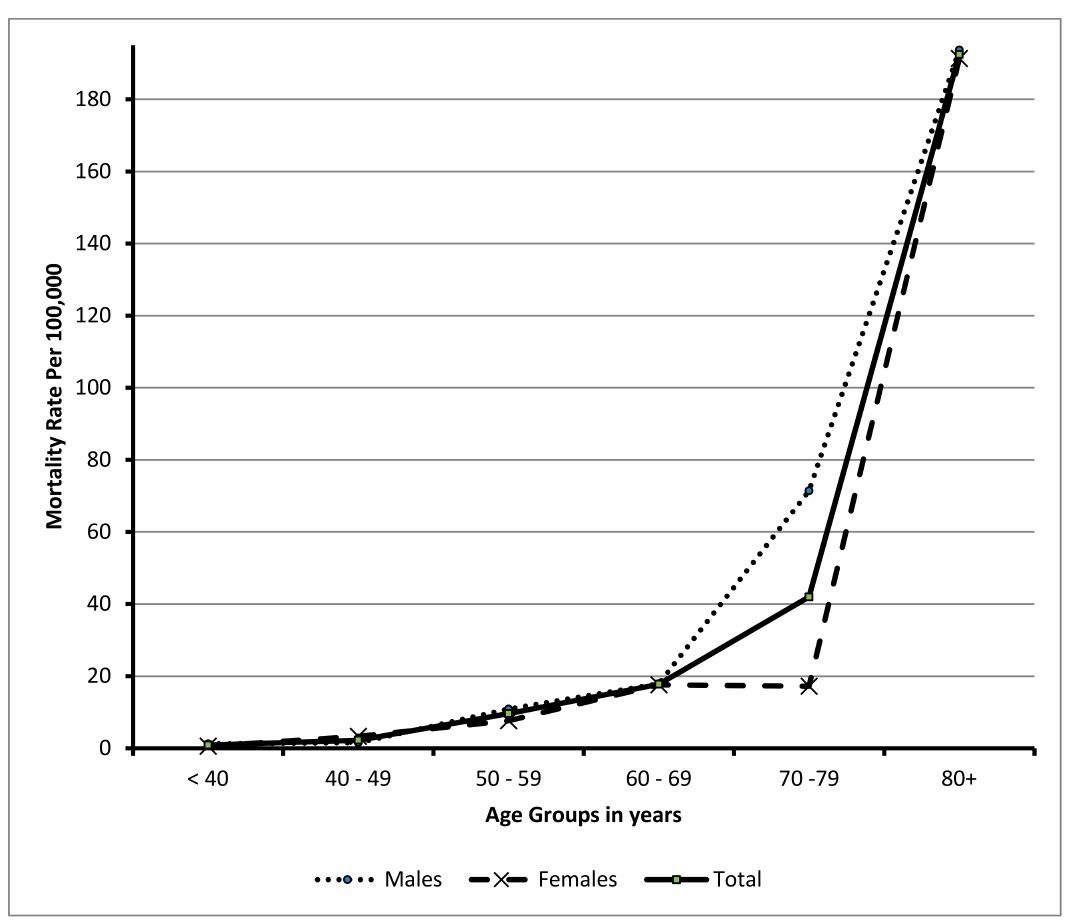
Figure 1. In-hospital stroke mortality rate per 100,000 population by different Age groups and